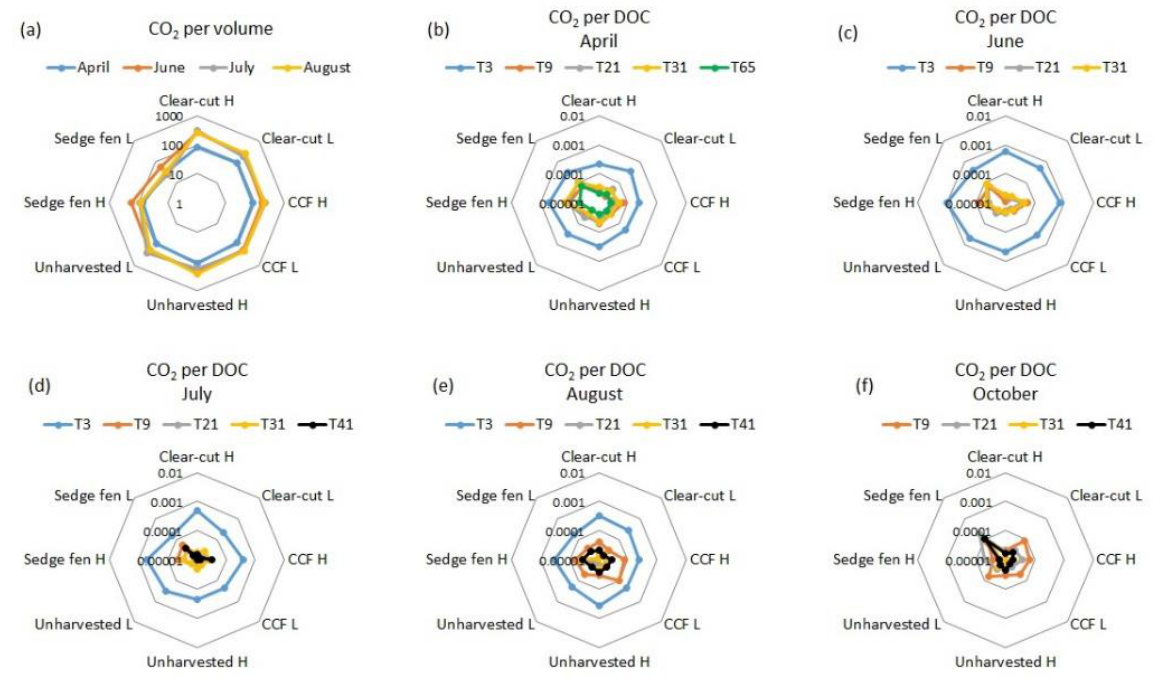
Figure 1. ( a ) Daily CO 2 production per water volume ( µ g CO 2 L − 1 day − 1 ) at T3 in April, June, July, and August in the water extracted from peat columns representing clear-cut, continuous cover forestry (CCF; 12 m 2 ), and unharvested forest in Paroninkorpi and alluvial sedge fen in Sudenpesänkangas. The CO 2 production expressed per DOC content ( µ g CO 2 -C DOC − 1 d − 1 ) during the same incubations in ( b ) April, ( c ) June, ( d ) July, ( e ) August, and ( f ) October. The incubations consisted of multiple